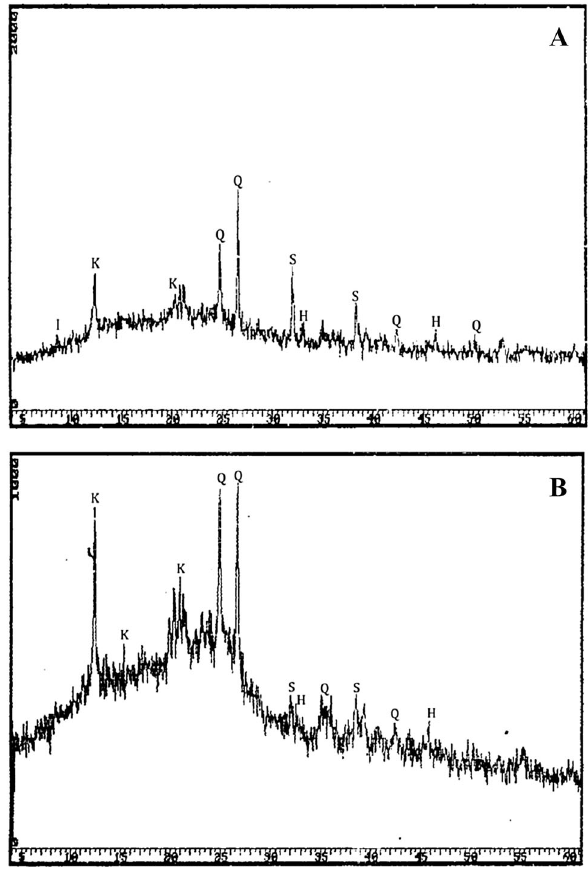
Fig. 2 XRD diffractograms of coal samples. a Ib-valley coal, b Umaria coal. H hematite, I illite, K kaolinite, Q quartz, S